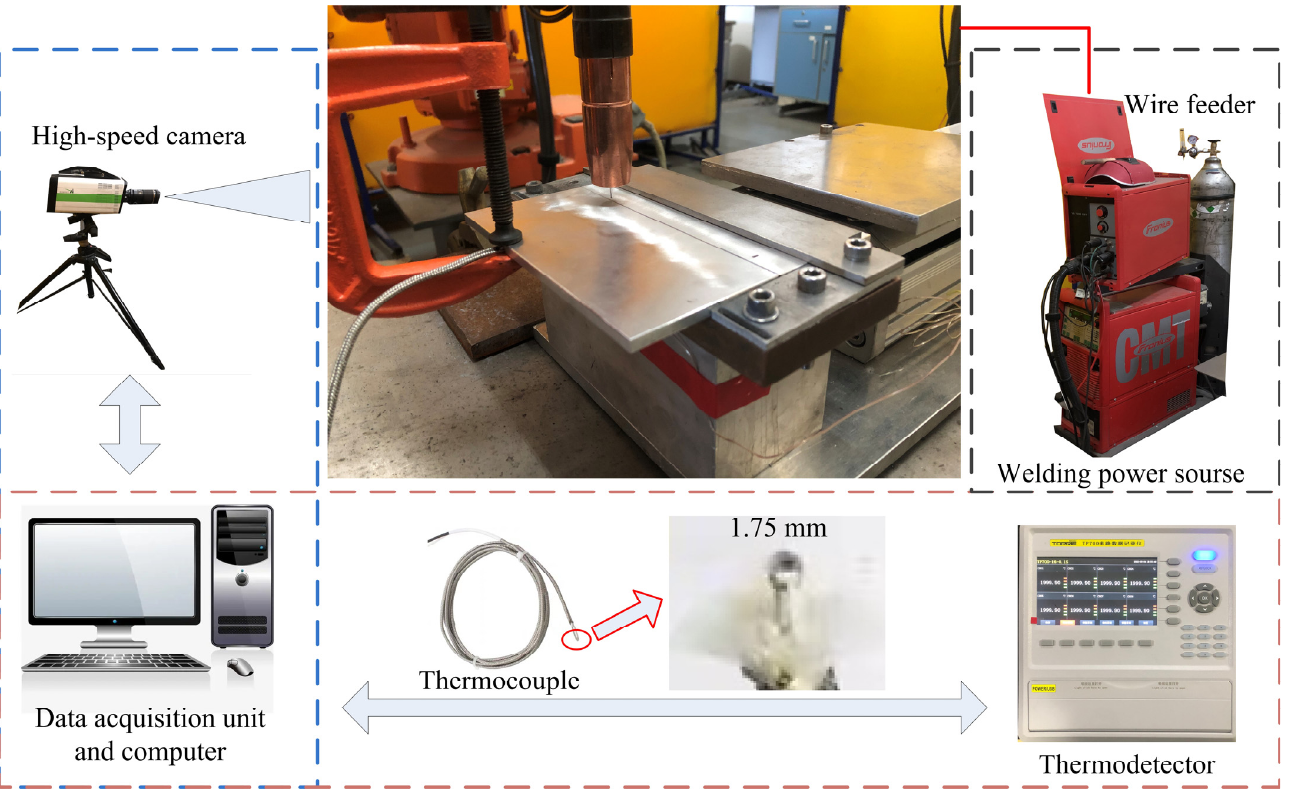
Figure 2. The setup of the high ‐ speed photography and temperature